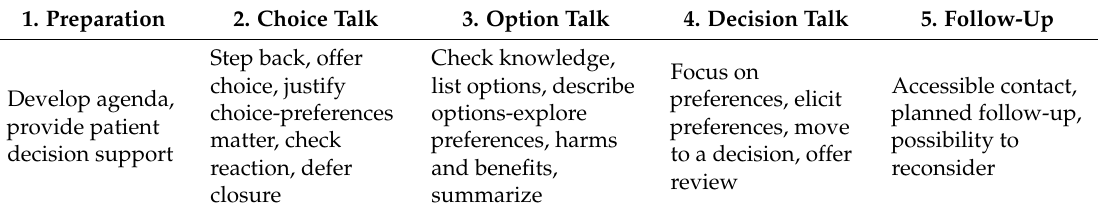
Table 3. A model for SDM as adapted from Grim, Rosenberg, Svedberg, & Schön, 2016. 1.